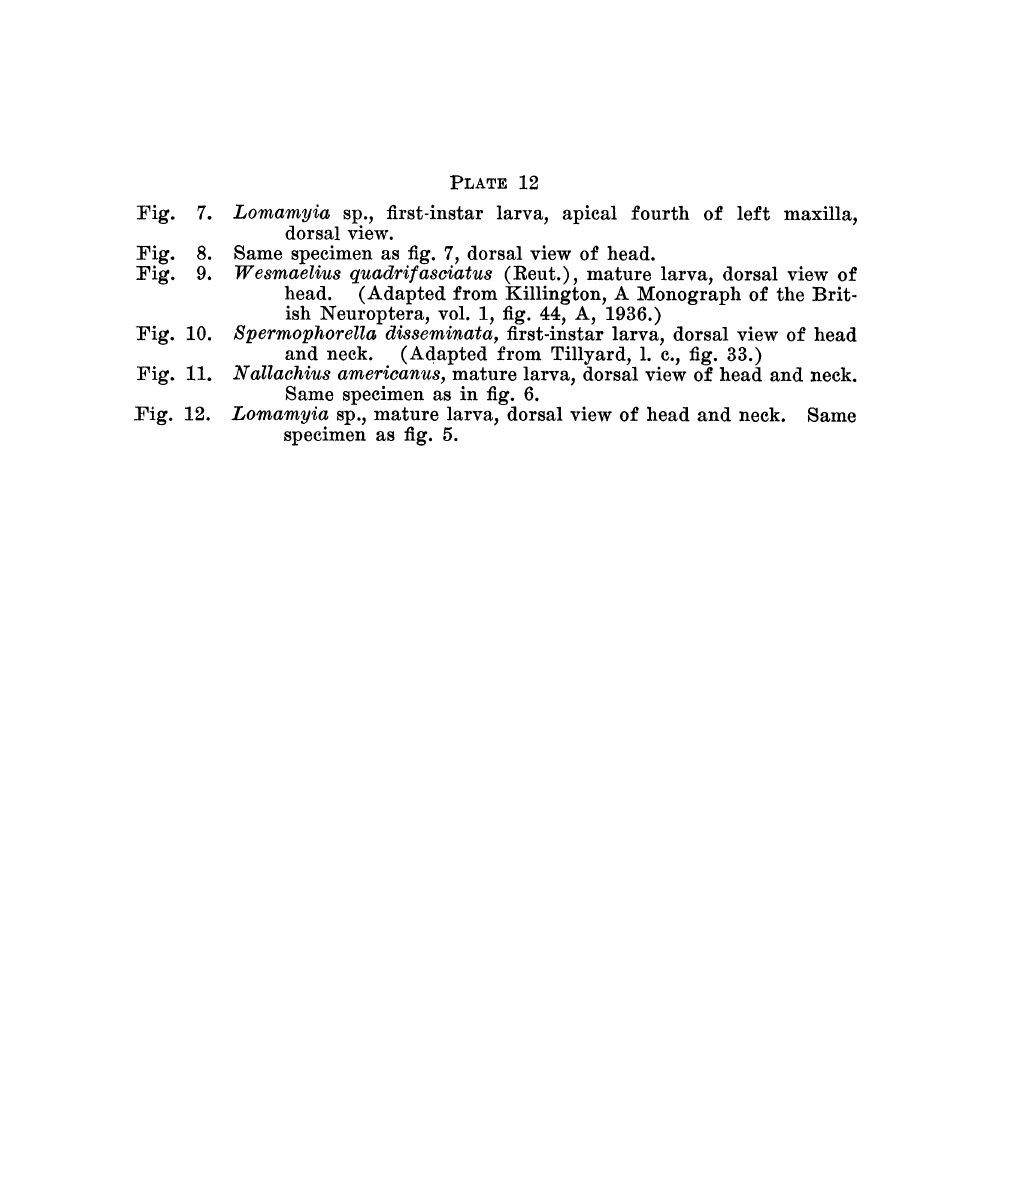
Fig. 7. Lomamyia sp., first-instar larva, apical fourth of left maxilla, dorsal view. Fig. 8. Same specimen as fig. 7, dorsal view of head. Fig. 9. Wesmaelius quadrifasciatus (Reut.), mature larva, dorsal view of head. (Adapted from Killington, A Monograph of the Brit- ish Neuroptera, vol. 1, fig. 44, A, 1936.) Fig. 10. Spermophorella disseminata, first-instar larva, dorsal view of head and neck. (Adapted from Tillyard, 1. c., fig. 33.) Fig. 11. Nallachius americanus, mature larva, dorsal view of head and neck. Same specimen as in fig. 6. :Fig. 12. Lomamyia sp., mature larva, dorsal view of head and neck. Same specimen as fig.